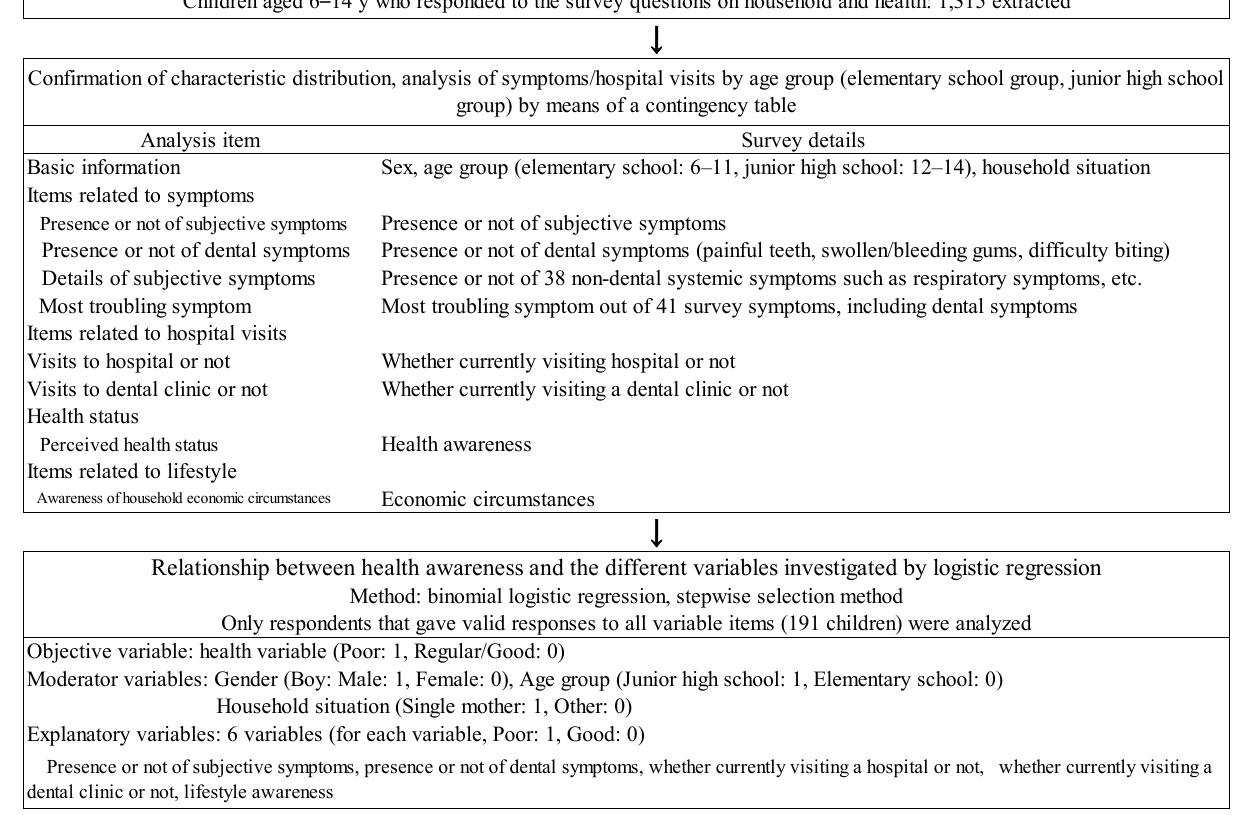
Figure 1. Flowchart of the data analysis in the present study.